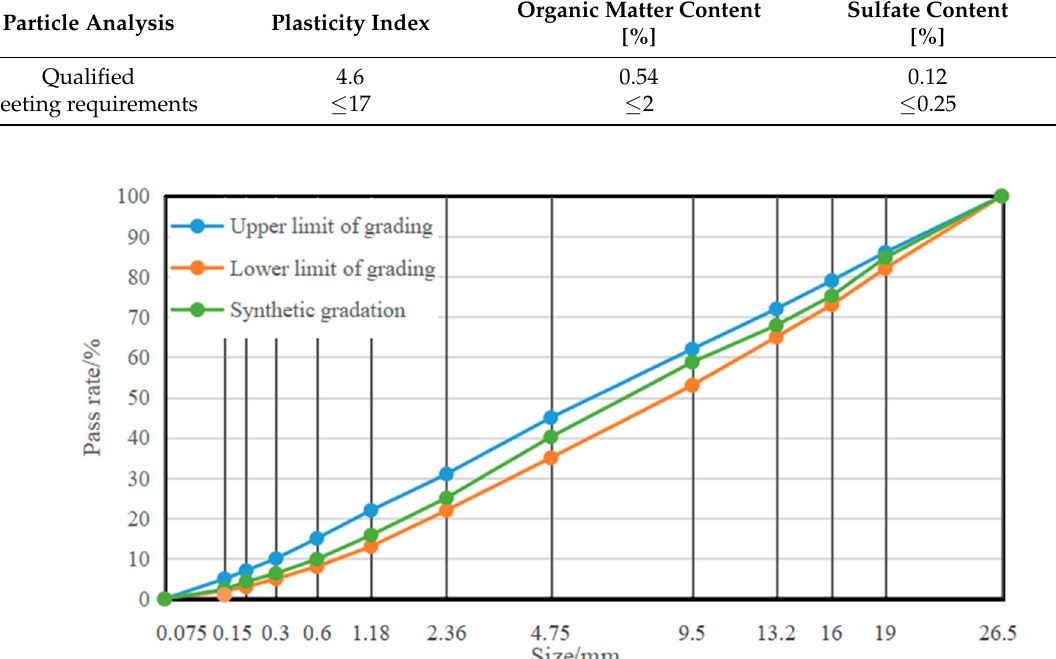
Figure 2. Aggregate grading curve.